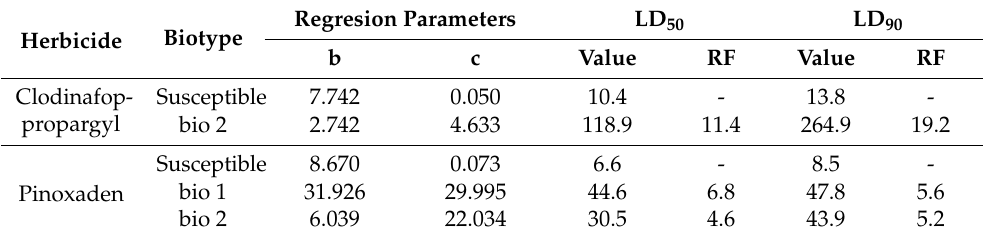
Table 2. Values of herbicide rate required to achieve the 50% (LD 50 ) and 90% (LD 90 ) mortality for each herbicide and population. The resistant factor (RF) is also presented for both